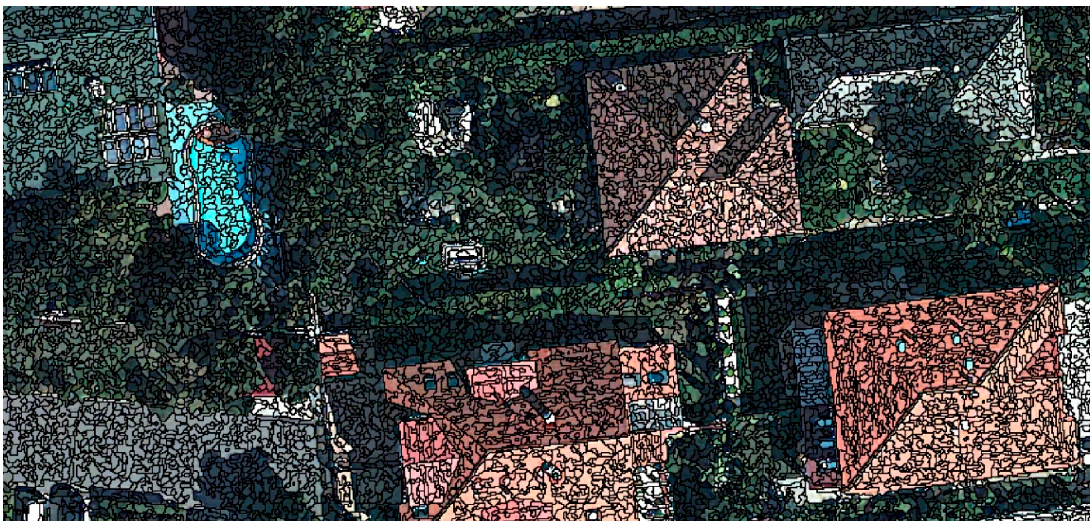
Figure 2. Example of segments on different land cover classes .